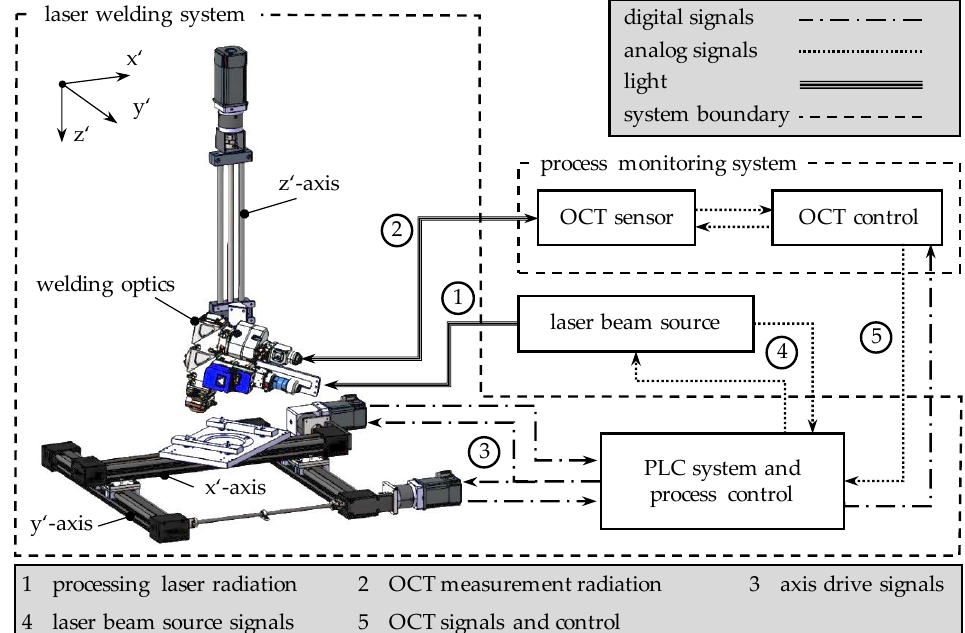
Figure 1. System architecture of the laser welding system with weld depth control and data streams within the system.